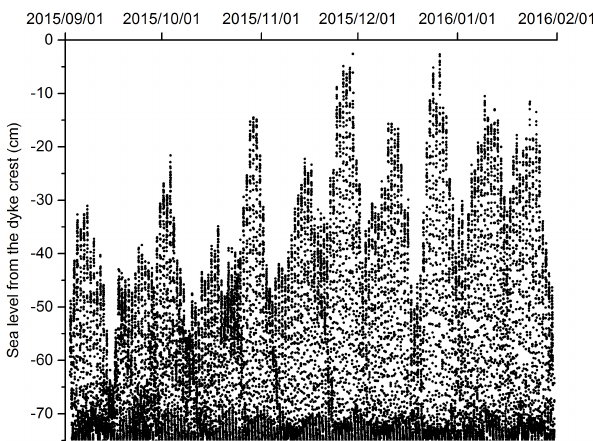
Figure 4. Sea level in Pluit bay with reference to the top of the dyke (Fig. 3b). Note that the top of the graph represents the top level of the dyke, and the y axis represents the maximum water level with reference to that point. Sea levels were recorded at 10min intervals between September 2015 and February 2016, and were derived by subtracting atmospheric pressures from total